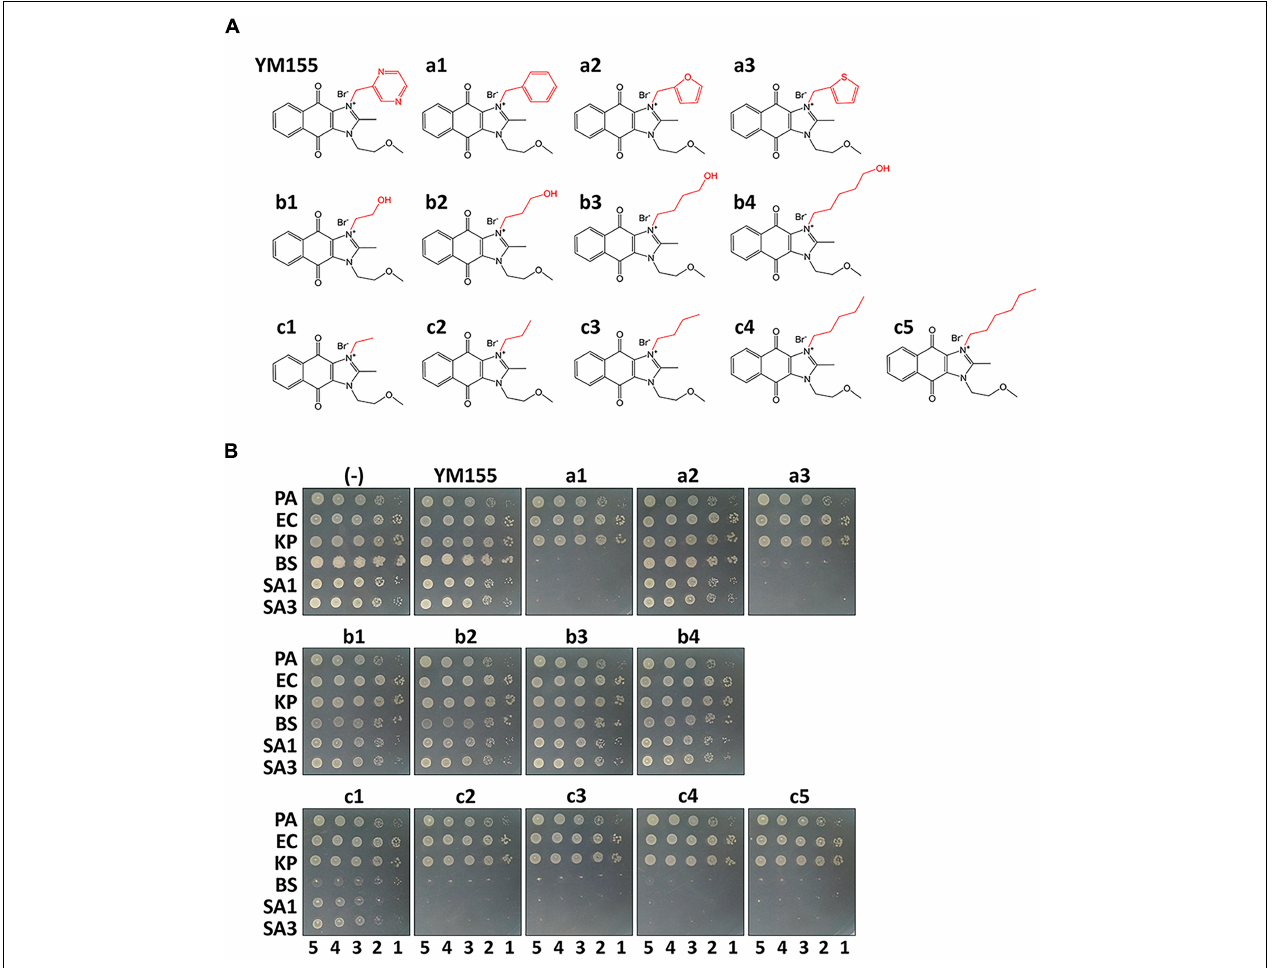
FIGURE 1 | Antibacterial activity in vitro . (A) Structure of YM155 and its analogs: Group a (a1 ∼ a3), b (b1 ∼ b4) and c (c1 ∼ 5) are analogs at N3 position of YM155. Group a has a ring structure, group b has a terminally hydroxylated alkyl chain, and group c has an alkyl chain. (B) Susceptibility of various bacterial strains to YM155 and its analogs: The Gram-negative ( Pseudomonas aeruginosa , PA; Escherichia coli , EC; and Klebsiella pneumoniae , KP) and Gram-positive ( Bacillus subtilis , BS; Staphylococcus aureus MSSA, SA1; and S. aureus MRSA, SA3) cells were grown to the logarithmic growth phase. Ten-fold serial dilutions of the cell cultures were spotted onto an LB agar plate (–), and LB agar plate containing YM155 (7.5 µ g/ml), or its analogs (7.5 µ g/ml). The numbers indicate the log(CFU) of the applied bacterial spots.